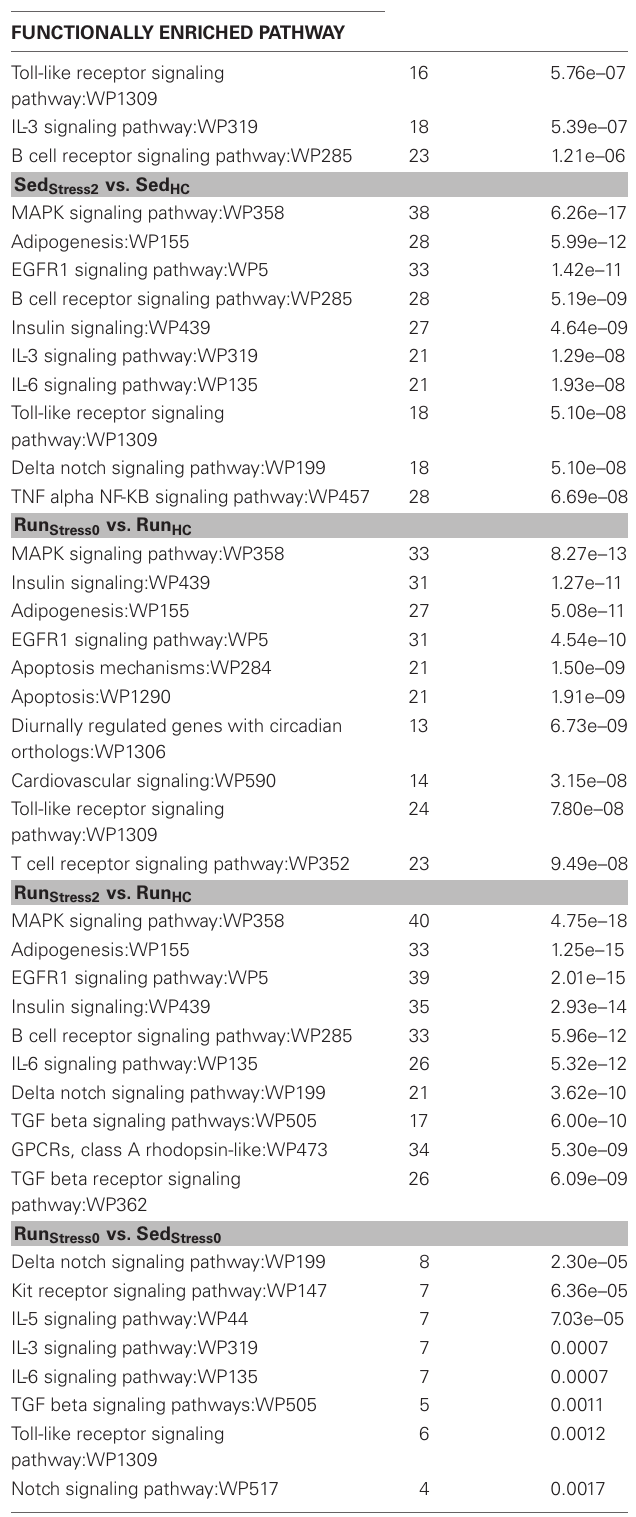
Table 2 | Wiki functionally enriched pathway categories generated from genes significantly differentially expressed at p < 0 . 05 in the DRN in response to exercise and/or